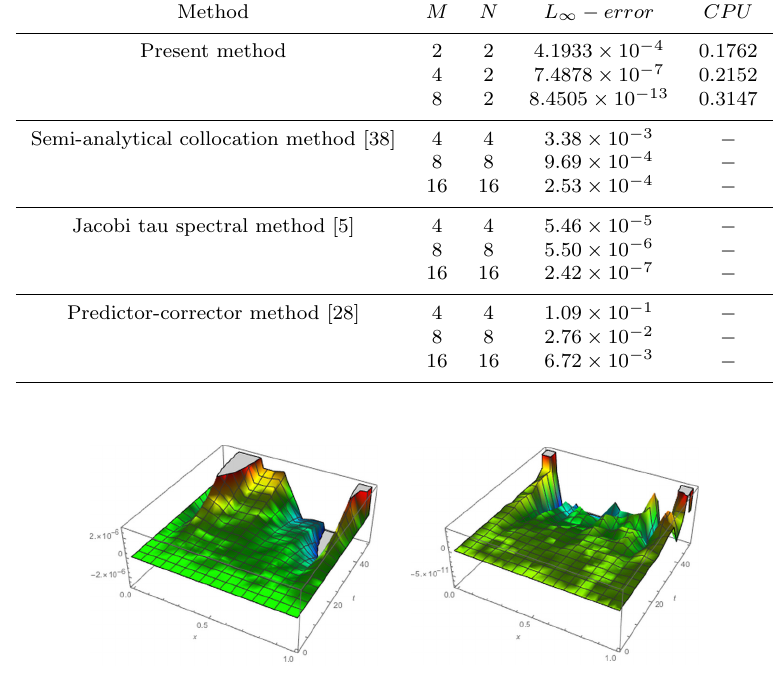
Table 2. Comparison of the maximum absolute errors for different values of M with methods in [5,28,38] with ν = 1 . 85 and β = 1 on the interval [0 , 1] × [0 , 1] for Example 3.